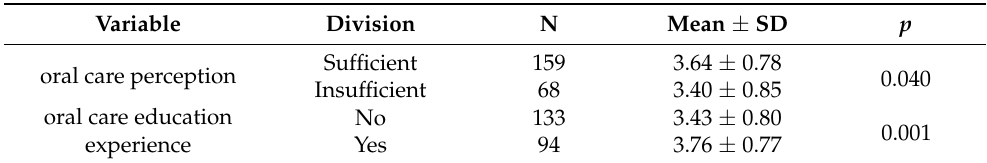
Table 5. Differences in attitudes towards the importance of oral care according to oral care perception and educational